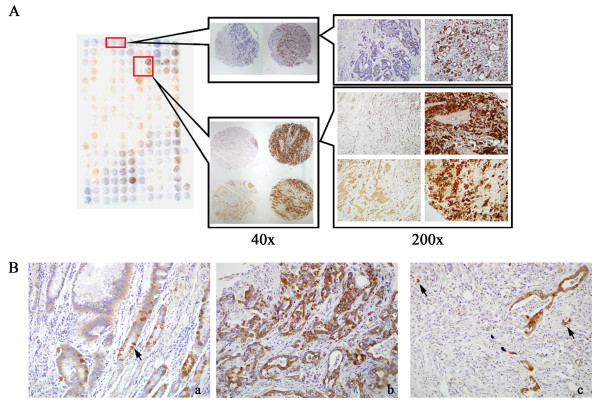
Immunoreactivity for Ezrin protein in gastric lesions. Immunohistochemical staining for Ezrin protein in the tissuearray of gastric adenocarcinoma (A). Scattered positive cells (arrows) for Ezrin protein were seen at the cytoplasm of basal reserve cells in gastric normal mucosa (B-a) (200×). The gastric cancer cells showed strongly and diffusely positive staining for Ezrin protein (B-b) (200×). Single scattered cancer cells and invasive cancer loci at the stroma showed intense immunoreactivity for Ezrin protein (arrows) (B-c) (200×).